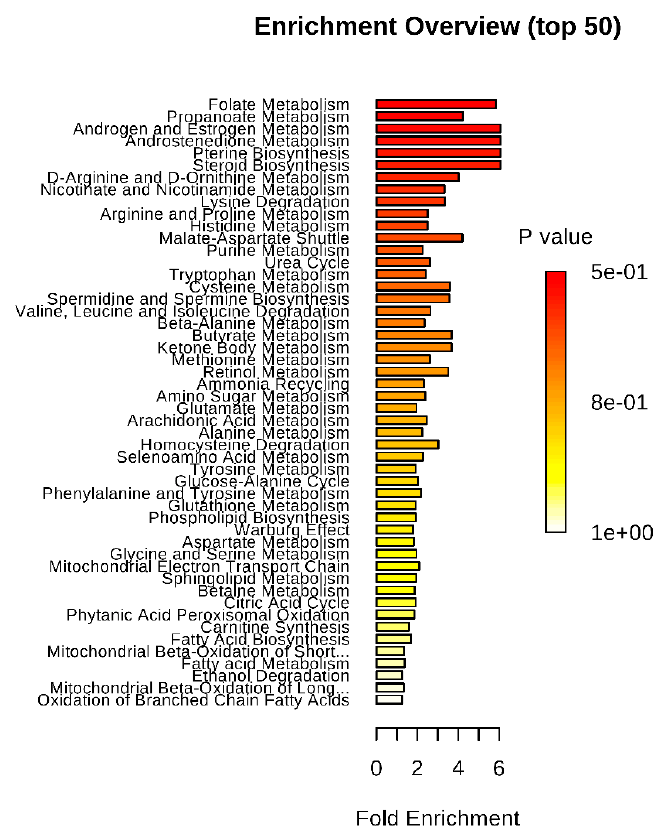
Figure 2. Results of the metabolite pathway enrichment analysis.